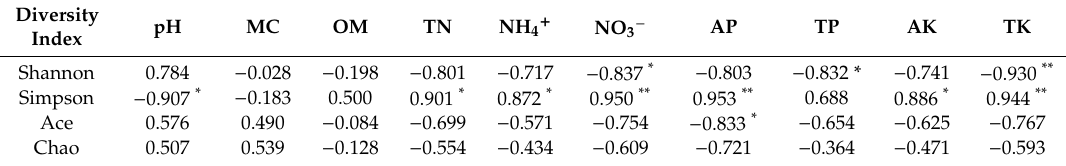
Table 4. Correlation analysis of diversity indices and soil properties. The correlation coe ffi cient and significance were obtained using Pearson’s correlation analysis. Significant values are shown as: * p < 0.05; ** p <